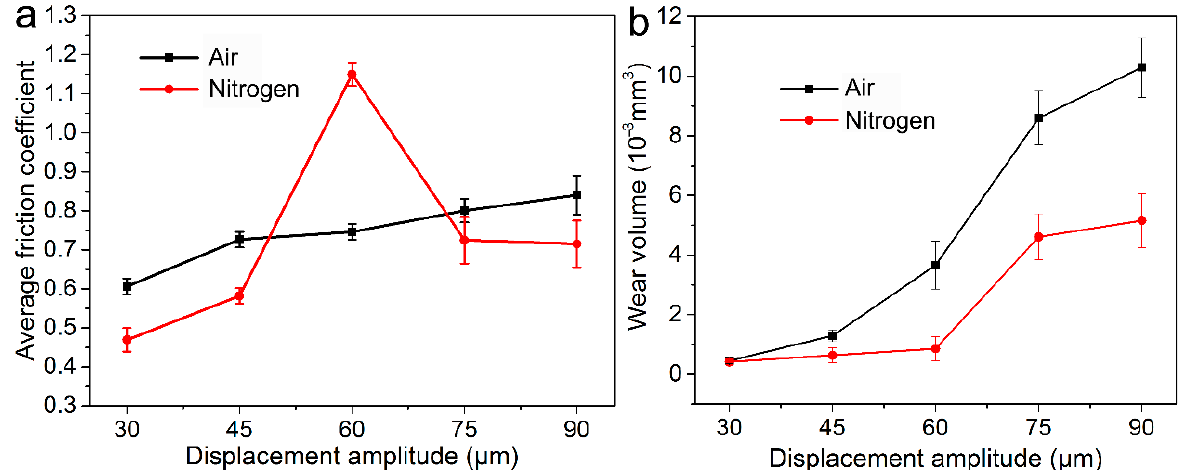
Figure 2. ( a ) The average friction coefficient and ( b ) wear volume of alloy 690 during fretting wear at different displacement amplitudes in air and nitrogen. The error bar is calculated by the standard deviation of three measurements.